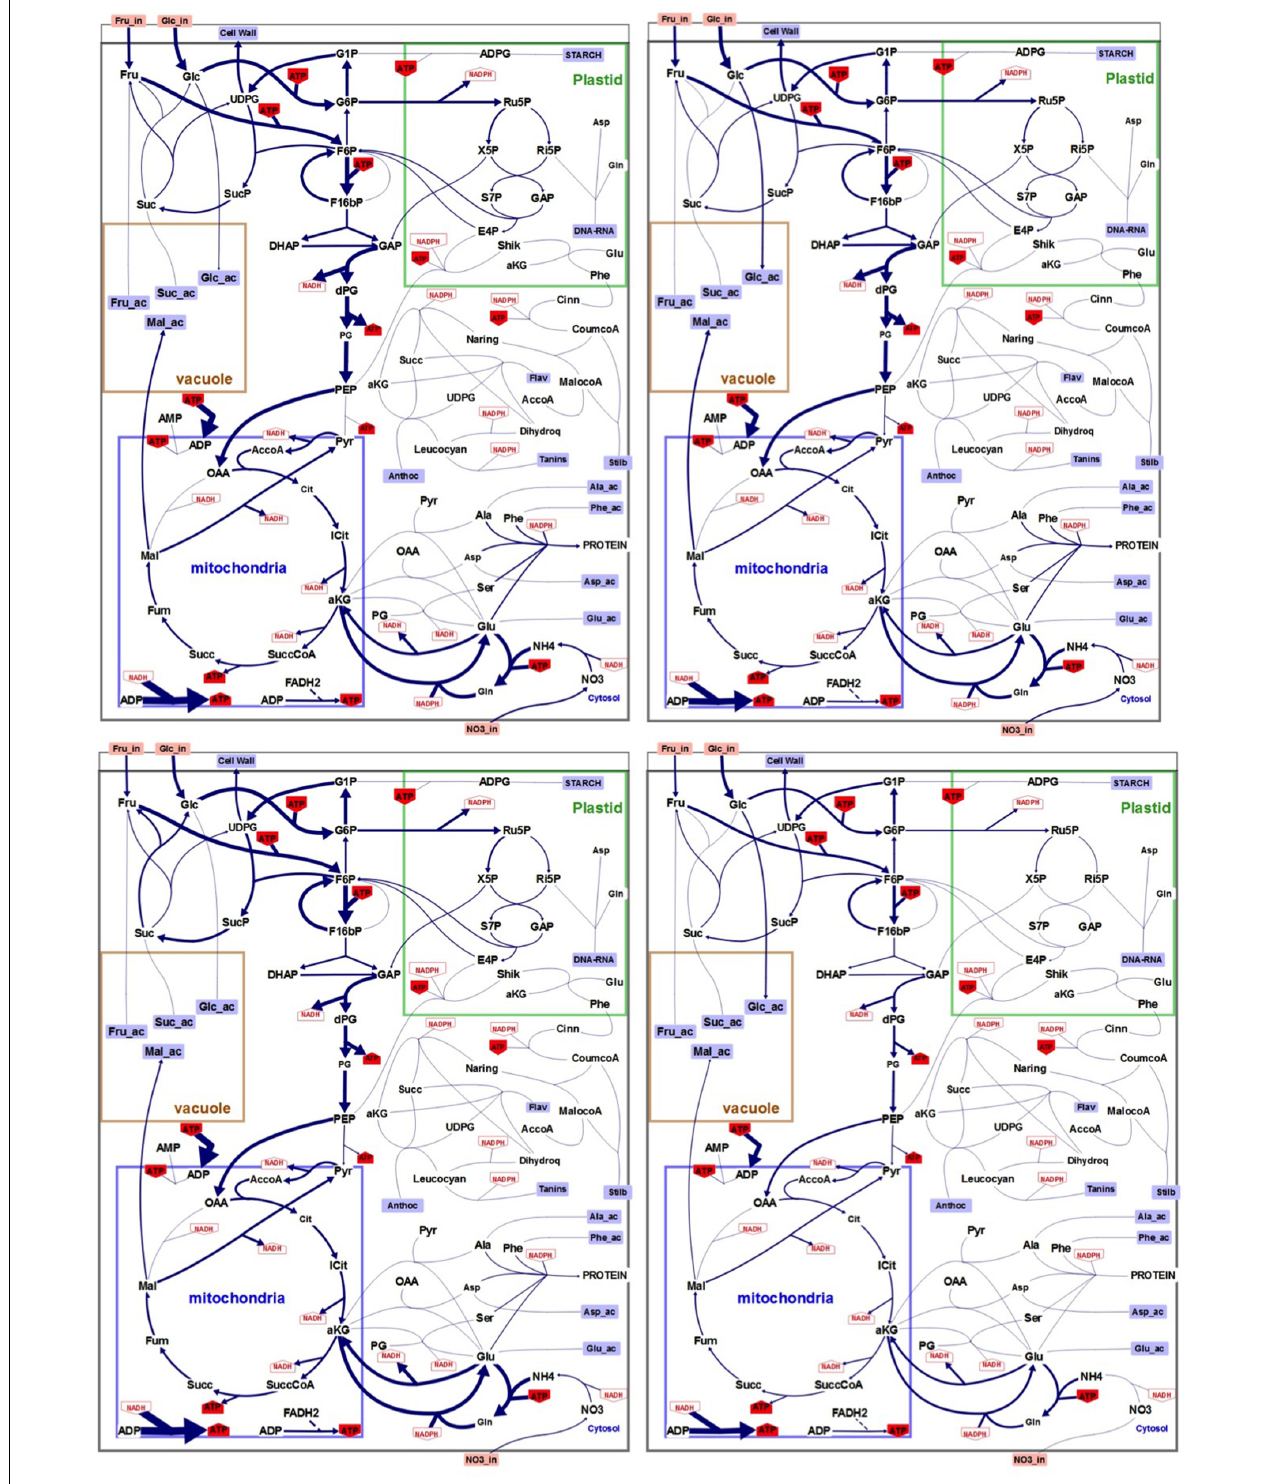
FIGURE 4 | Flux maps generated through FBA modeling. Upper left panel: control conditions (N), day 4. Upper right panel: low nitrogen (N–), day 4. Lower left panel: control conditions (N), day 6. Lower right panel: (N–), day 6. Size of the arrows is proportional to flux absolute intensity. Imported metabolites are in orange boxes. External metabolites are in blue squares. NADH, NADPH, and ATP use by each reaction are in red. Irreversible reactions are indicated by unidirectional arrows. The compartmentation indicated on the figure is reminiscent of the physiological situation. Illustration was designed with the software Omix (Droste et al., 2011).